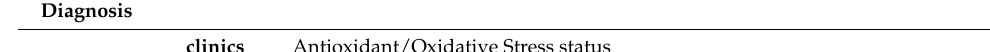
Table 1. Precision Medicine in Diagnosis and Therapy of Diseases associated with Redox